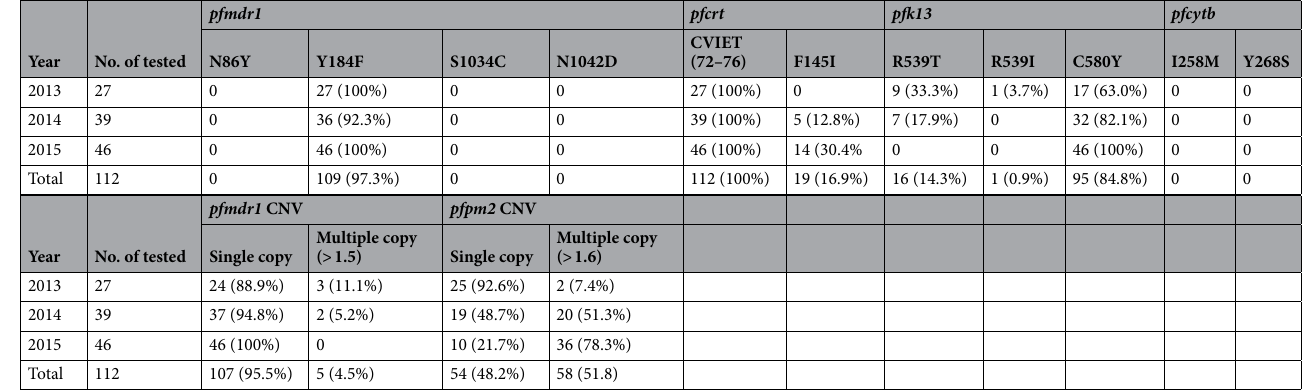
Table 2. Mutations of malaria resistance molecular markers of P. falciparum in Thailand between 2013 and 2015.